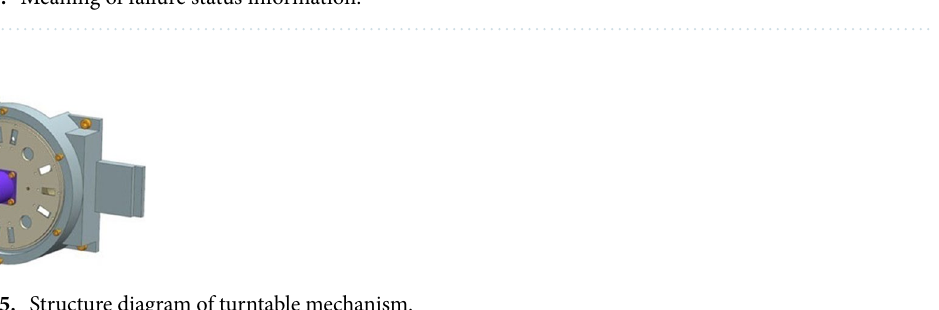
Table 1. Meaning of failure status information.